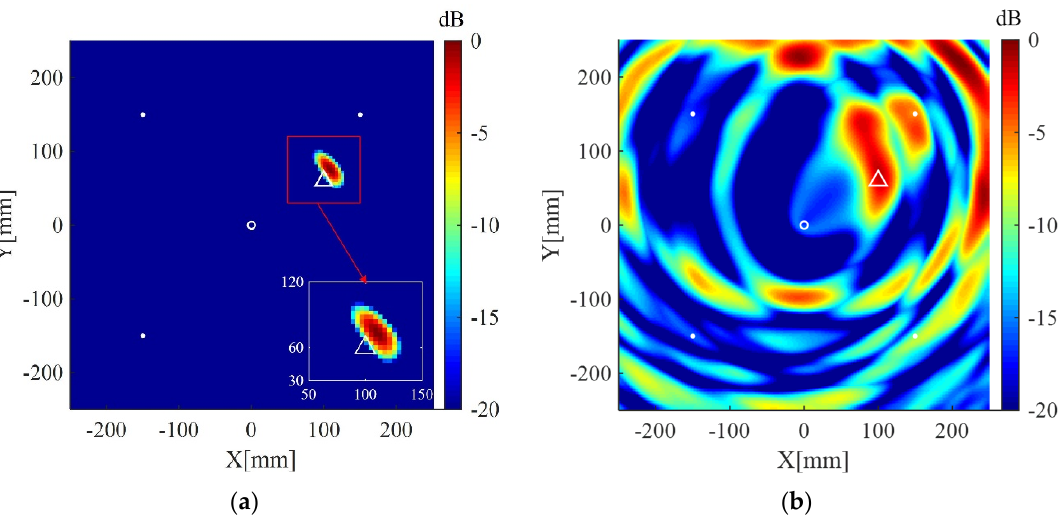
Figure 4. Imaging results in simulation I using: ( a ) the weighted structured sparse reconstruction ‐ based Lamb wave imaging method (the location error is 17 mm); ( b ) the delay ‐ and ‐ sum imaging method (the location error is 195 mm). White dots denote locations of measuring points, the white circle denotes the location of excitation source, and the white triangle denotes the center of the crack I.